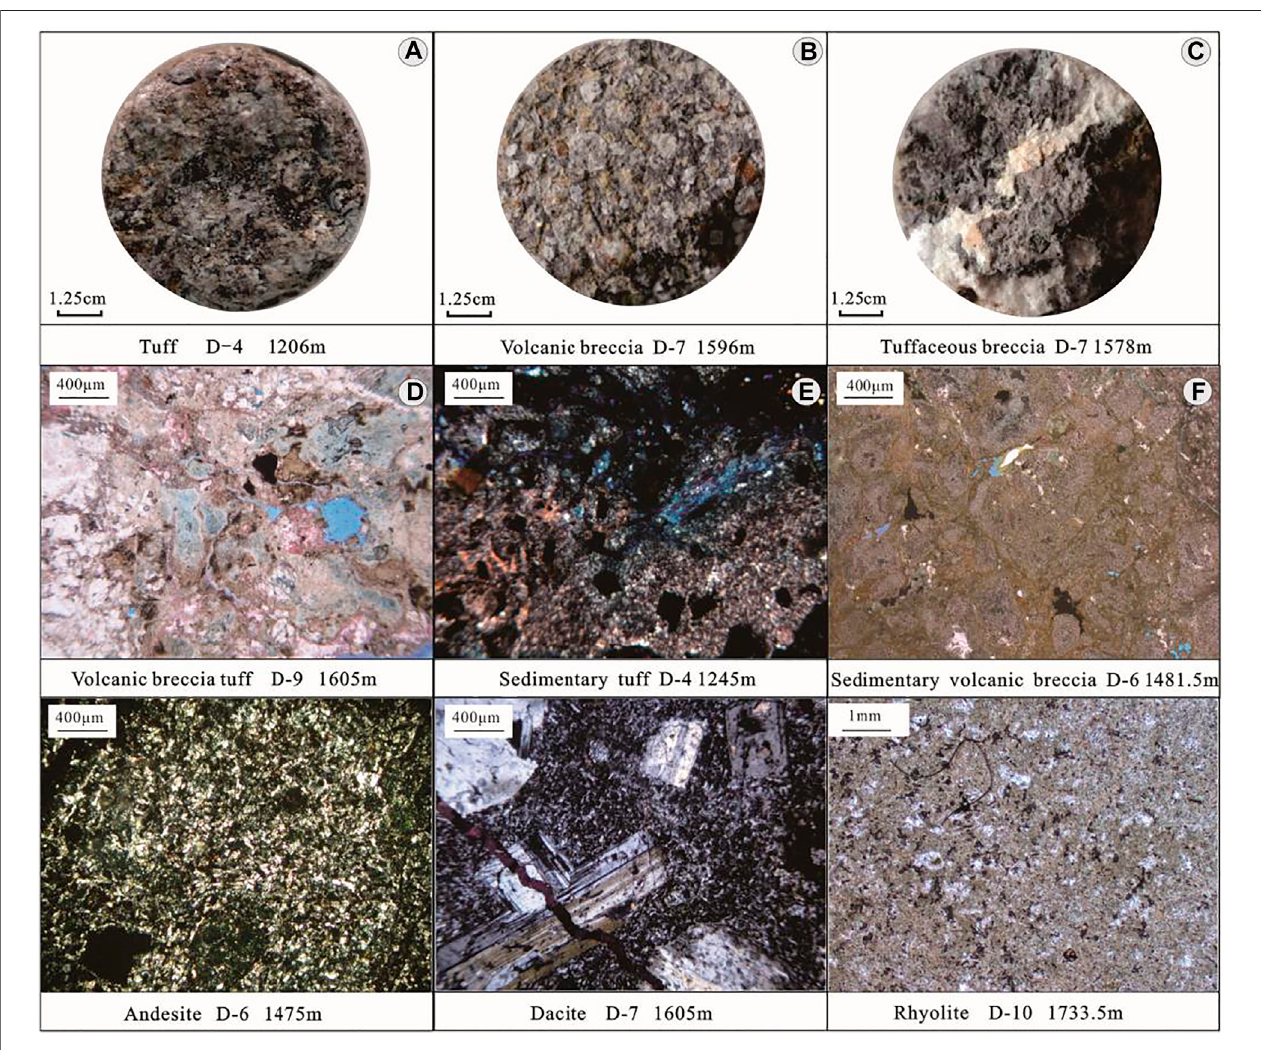
FIGURE 2 | Lithology photos of volcanic rocks in the D Oil fi